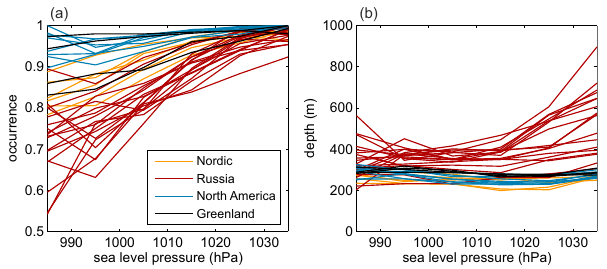
Fig. 7. Dependency between sea level pressure and (a) occurrence, and (b) median depth of humidity inversions at each